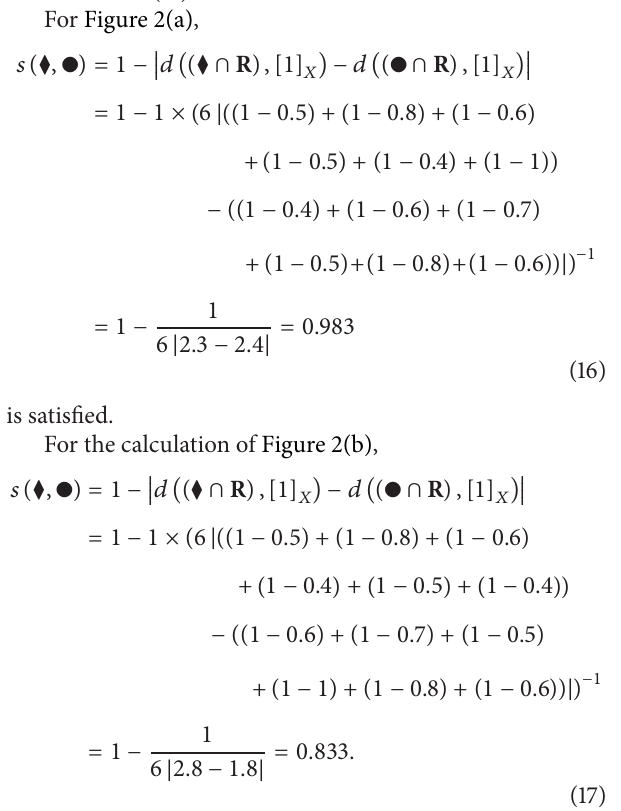
continuous data distributions; this property is verified by the similarity measure calculation of Figures 2(a) and 2(b).